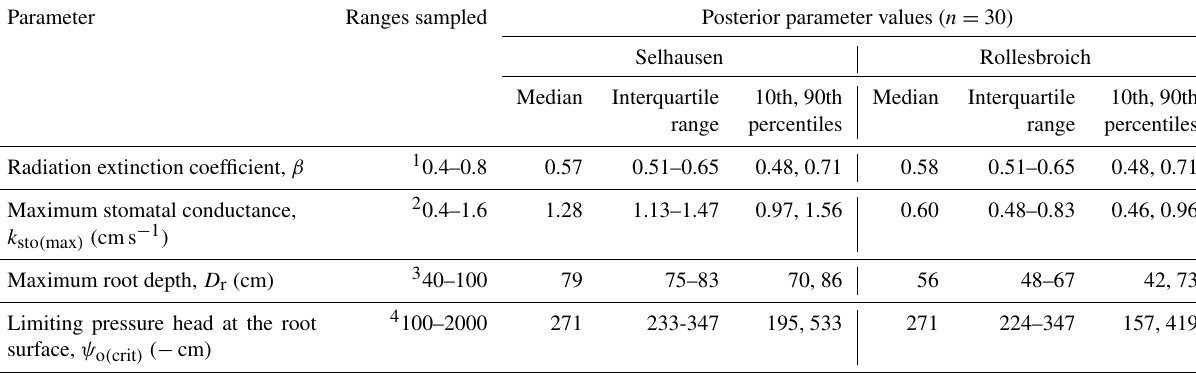
Table 5. Uncertain parameters: initial ranges, data sources and posterior parameter ranges.